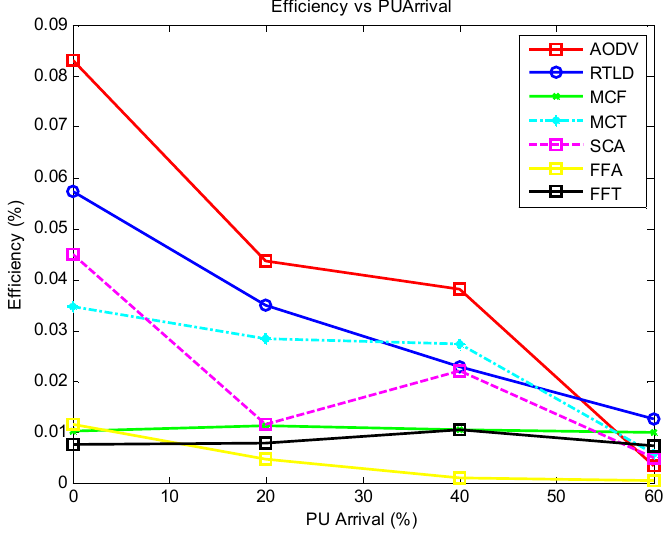
Figure 7. Energy efficiency of all protocols versus primary user